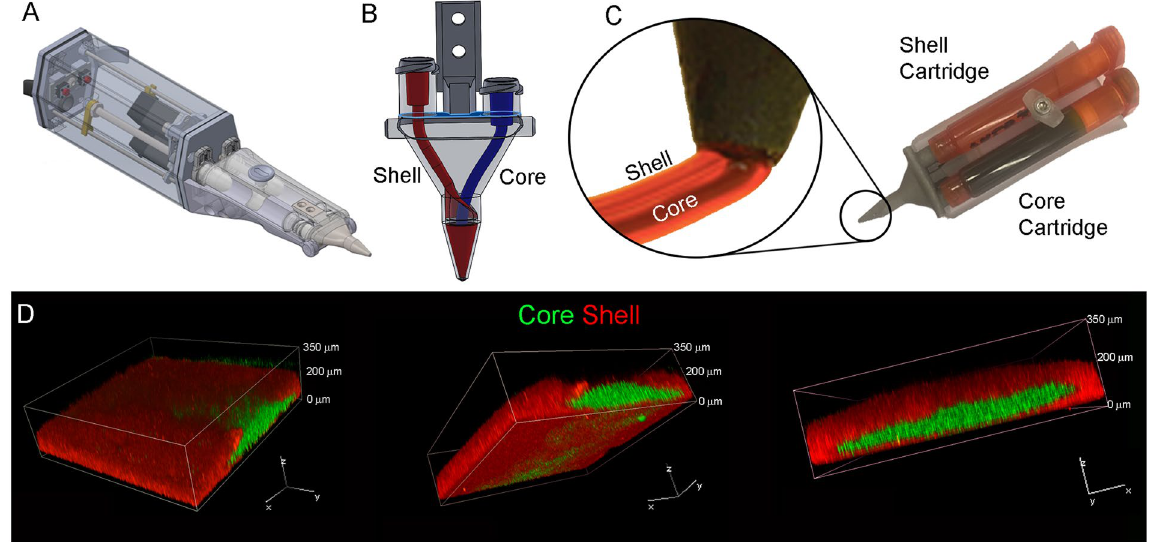
Figure 4. Core/Shell 3D printing by co-axial extrusion. ( A ) Schematic representation of the 3D co-axial handheld printer. ( B ) Schematic representation of the co-axial nozzle. ( C ) Picture of the cartridges dedicated to Core and Shell loading in the printer, with relative magnification of the nozzle during co-axial deposition. ( D ) Representative 3D rendered confocal images of Core/Shell printed sample labeled with fluorescent beads. The Shell (GelMa/HAMa plus LAP 0.1%) is shown in red channel, while the Core (GelMa/HAMa) is shown in green channel. z -stacks were acquired every 10 µ m and 3D rendering was performed with NIS elements software using the Alpha - blending algorithm. A Nikon Plan Fluor 10x DIC L N1 NA0.3 objective lens was used. The panel shows the same image representative of 3D rendered of superimposed green and red channels in three different